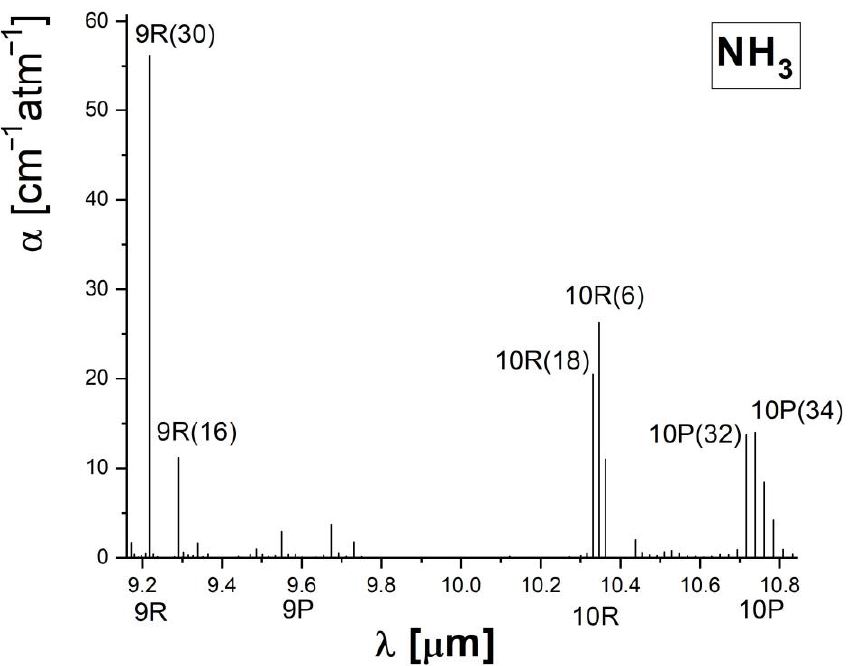
Figure 3. Ammonia absorption coefficients of CO 2 laser wavelengths lights on 9P, 9R, 10P, and 10R branches [46].